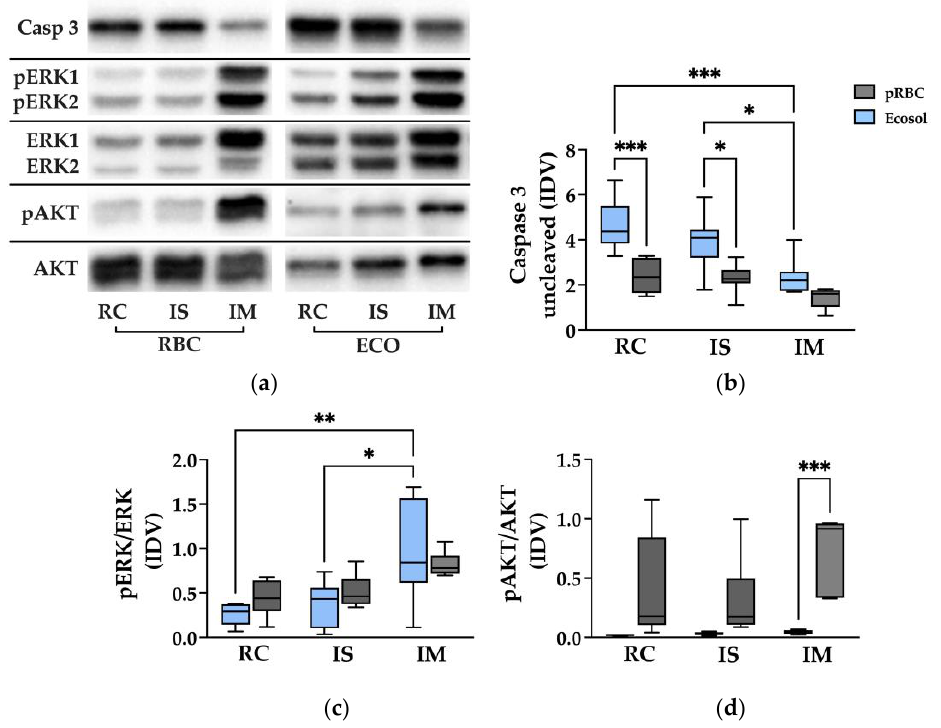
Figure 7. Western Blot analysis of Casp 3, pERK/ERK and pAkt/Akt. ( a ) Representative WB analysis of different kidney areas in both groups; and ( b – d ) statistical analysis of Casp 3, pERK/ERK and pAkt/Akt protein levels; * p < 0.05, ** p < 0.01; *** p < 0.001; VIN Vinculin; Casp 3 Caspase 3; ERK1/2 extracellular-signal regulated kinases 1/2; pERK1/2 phosphorylated extracellular-signal regulated kinases 1/2; Akt protein kinase B; pAkt phosphorylated protein kinase B; IDV integrated density value; RC cortex; IS inner stripe; IM inner medulla.